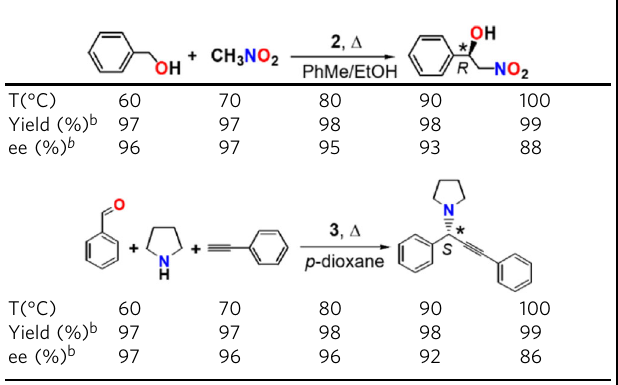
a Reactions are carried out under the optimized conditions except in dark by heating b Yield and ee are determined by GC and chiral HPLC, respectively (Supplementary Fig.